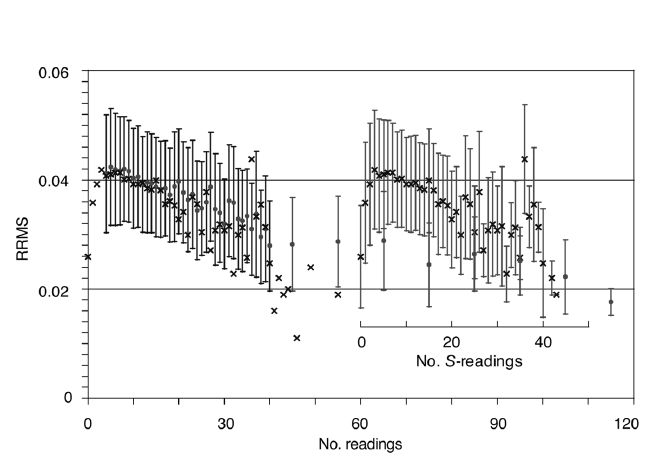
Fig. 6. Average of relative RMS (dimensionless, eq. (3.1)) of the locations and its associated standard devia- tion versus the number of P - (dots) and S -wave (crosses) arrival-time data actually used in the location. Data per- taining to earthquakes with more than 40 phases have been grouped in classes of 10 phases. To avoid overlap- ping bars, the standard deviation bars versus the number of S readings have been moved to the right side of the figure, whereas at the left side only the average values (crosses) are